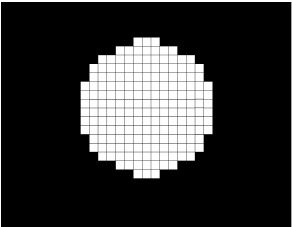
Figure 3. Schematic illustration of a local surface element (white circle). The small squares represent the pixels in the image of the surface